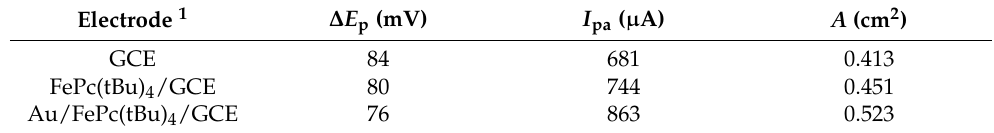
Table 1. ∆ E p , I pa , and A values of the GCE, FePc(tBu) 4 /GCE, and Au/FePc(tBu) 4 /GCE